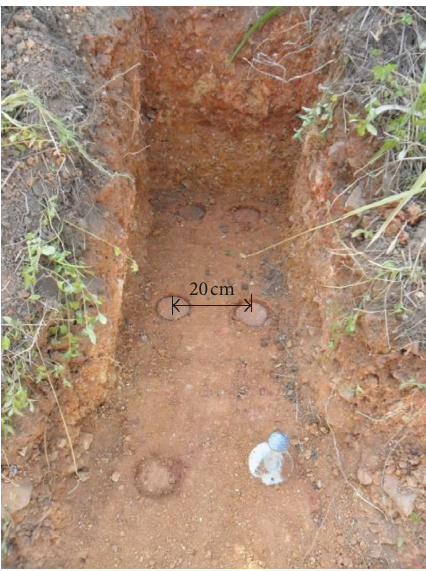
Figure 6: Locations of soil samples.